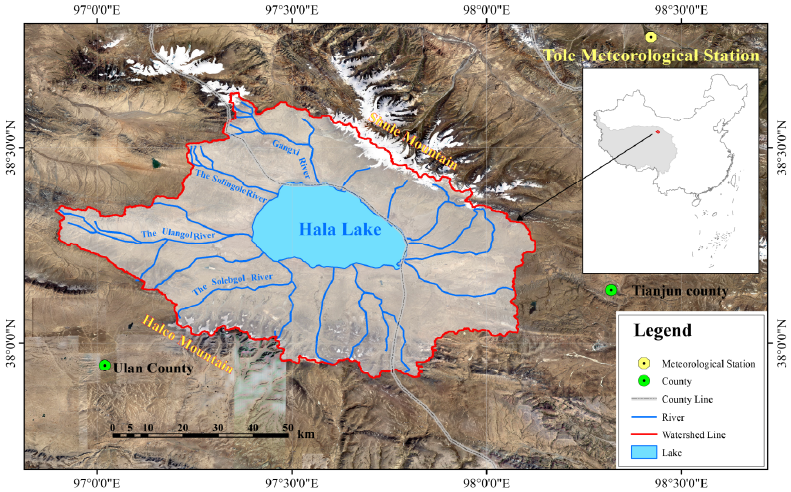
Figure 1. Map of the Hala Lake Basin.